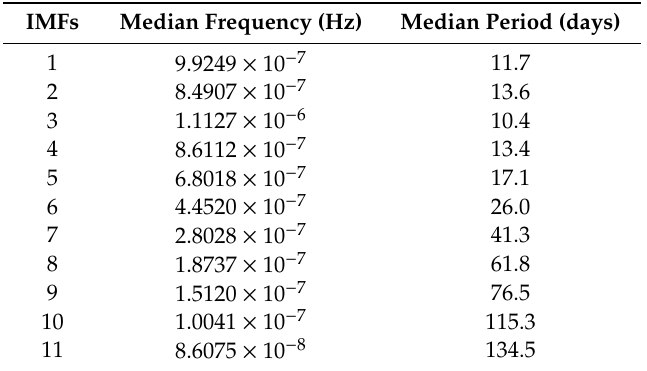
Table 2. Median frequency and period for the 11 IMFs shown in Figure